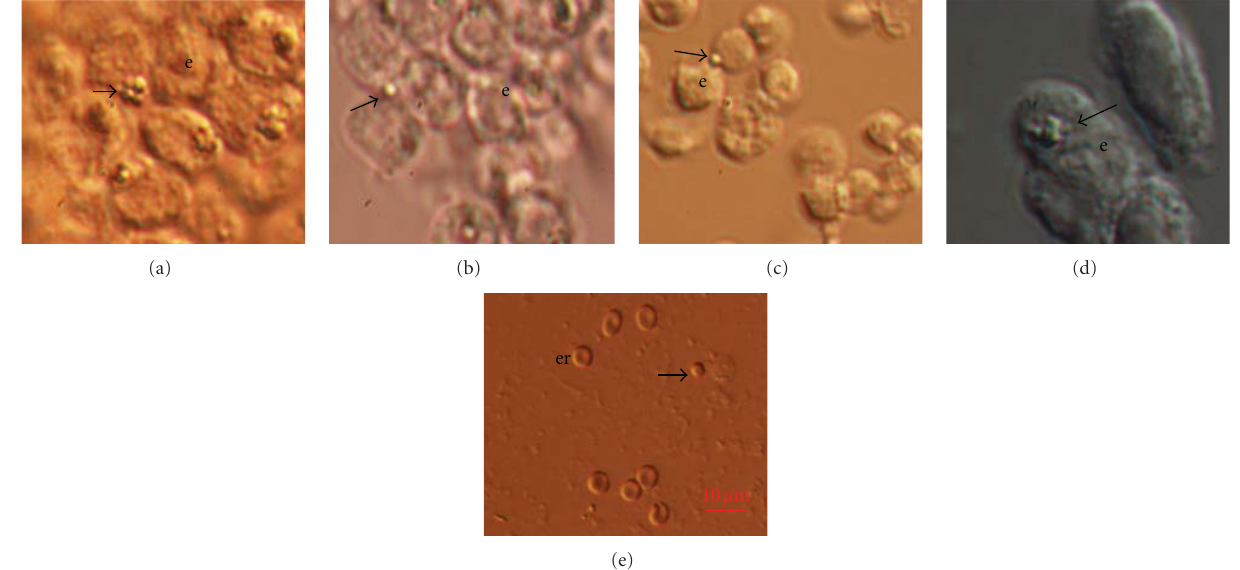
Figure 3: Small round cells (arrows)—putative stem cells in the ovarian surface epithelium. (a–d) Among the epithelial cells in the ovarian surface epithelium scrapings (magnification 6,000-times). (e) Among the erythrocytes in a scraped population of cells (magnification 200- times). (Inverted microscope, dic-Nomarski illumination, immersion objective for magnification 6,000-times, and Ho ff man illumination for magnification 200-times.) e: epithelial cells, er: erythrocytes.